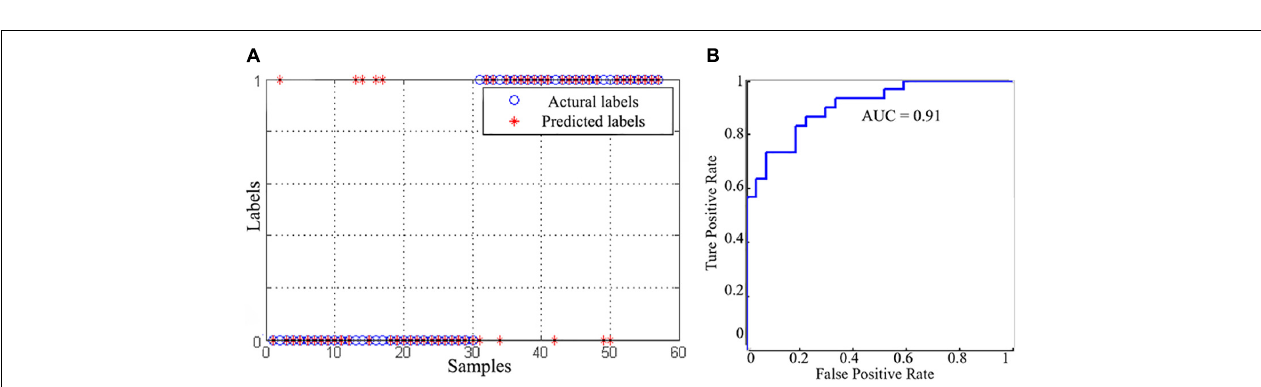
FIGURE 3 | Discriminative gFCD, lFCD, and lrFCD between HCs and individuals with IA . (A) Discriminative gFCD. (B) Discriminative lFCD. (C) Discriminative lrFCD and (D) The summary of these discriminative FCDs based on BrainNet Viewer (http://www.nitrc.org/projects/bnv/) (Xia et al., 2013). The red nodes represent the interoceptive reward awareness system, the blue nodes represent the impulsive habit system, and the yellow nodes represent the reflecting system. The red up arrows represent increased FCDs, while the blue down arrows represent decreased FCDs. g, gFCD; l, lFCD; lr, lrFCD; L, left; R, right; SFC, superior frontal cortex; OFC, orbitofrontal cortex; MFC, middle frontal cortex; IFC, inferior frontal cortex; PMC, premotor cortex; MCC, middle cingulate cortex; AG, angular gyrus.